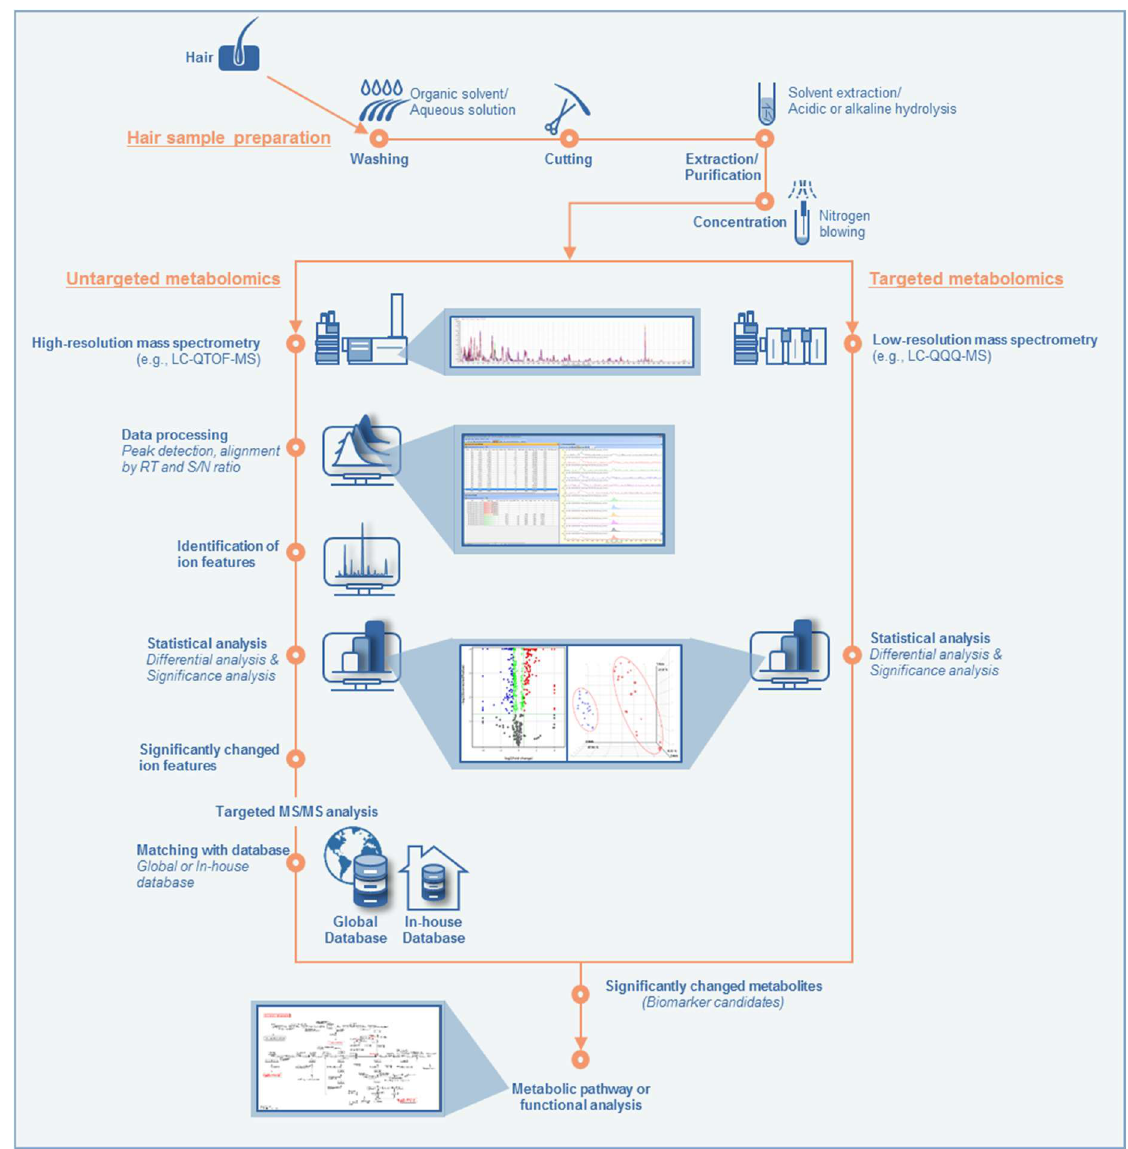
Figure 2. Workflow of untargeted and targeted approaches in hair metabolomics. LC-QTOF-MS, liquid chromatography-hybrid quadrupole time-of-flight mass spectrometry; LC-QQQ-MS, liquid chromatography-triple quadrupole mass spectrometry; RT, retention time; S / N ratio, signal-to-noise ratio.